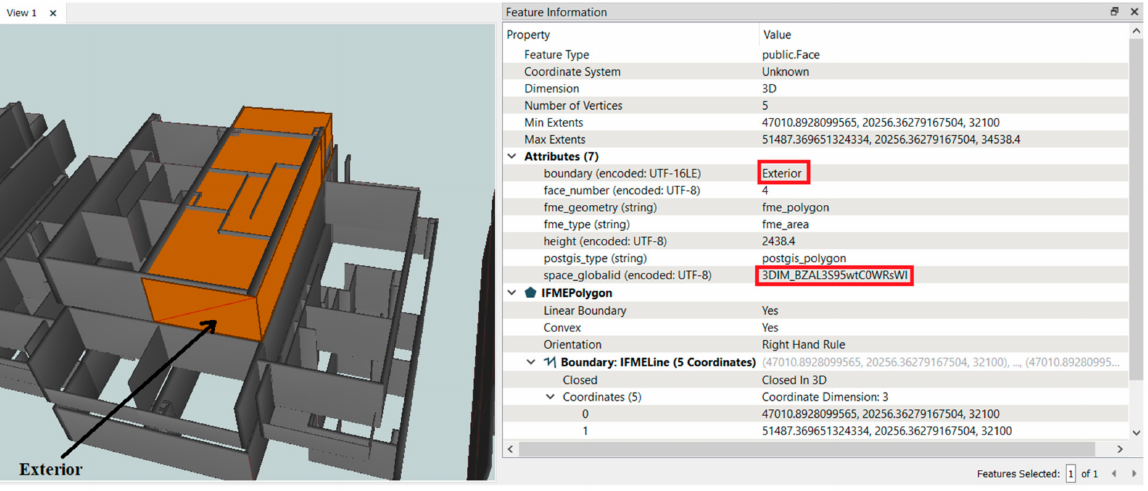
Figure 22. An exterior boundary for the lot with the Globalid: